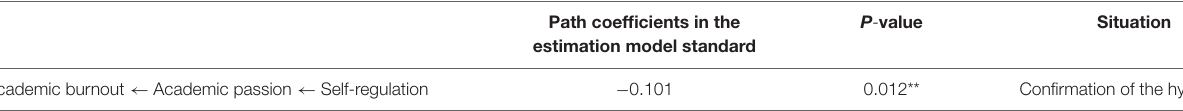
TABLE 8 | Relationship between self-regulation and academic burnout and the mediating role of academic achievement.